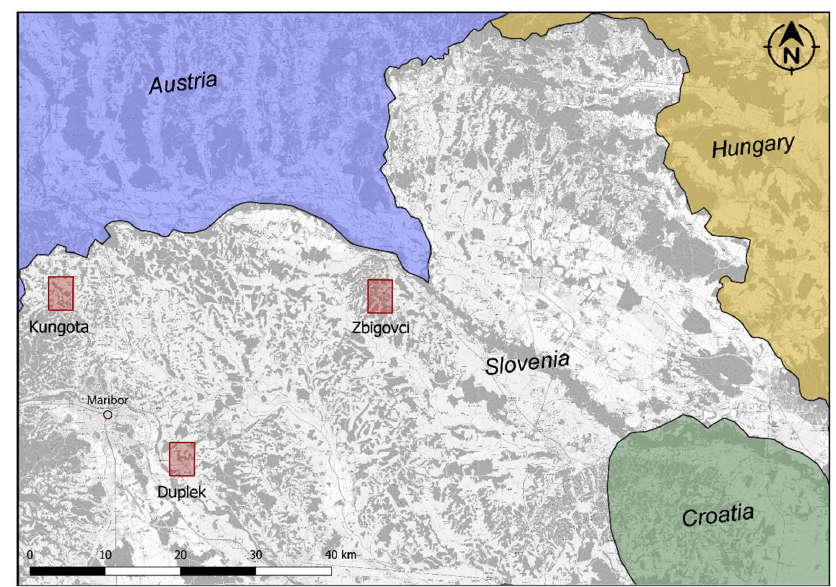
Figure 1. The location of the study areas Duplek, Kungota and Zbigovci. Analyzed DOF sheets (national topographic and CAP mapping units) are marked in red.